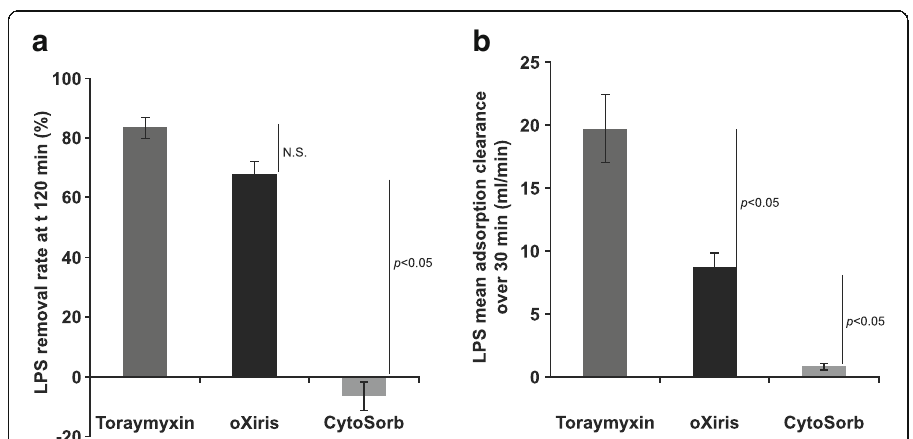
Fig. 2 LPS removal with oXiris, Toraymyxin, and CytoSorb. a LPS removal rate at t120 min. b LPS mean adsorption clearance over 30 min. Abbreviations : LPS lipopolysaccharide, N.S . not